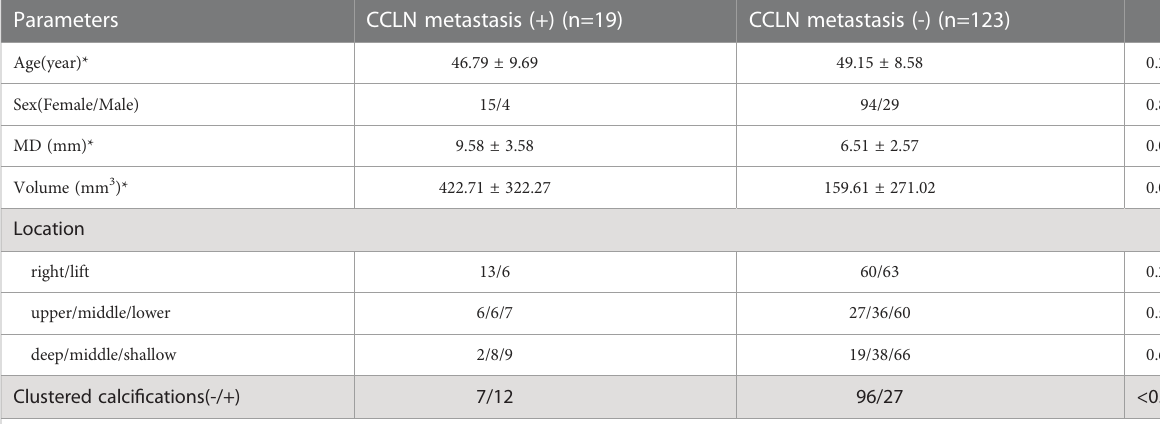
TABLE 5 Univariate analysis of CCLN metastasis in T1N0M0